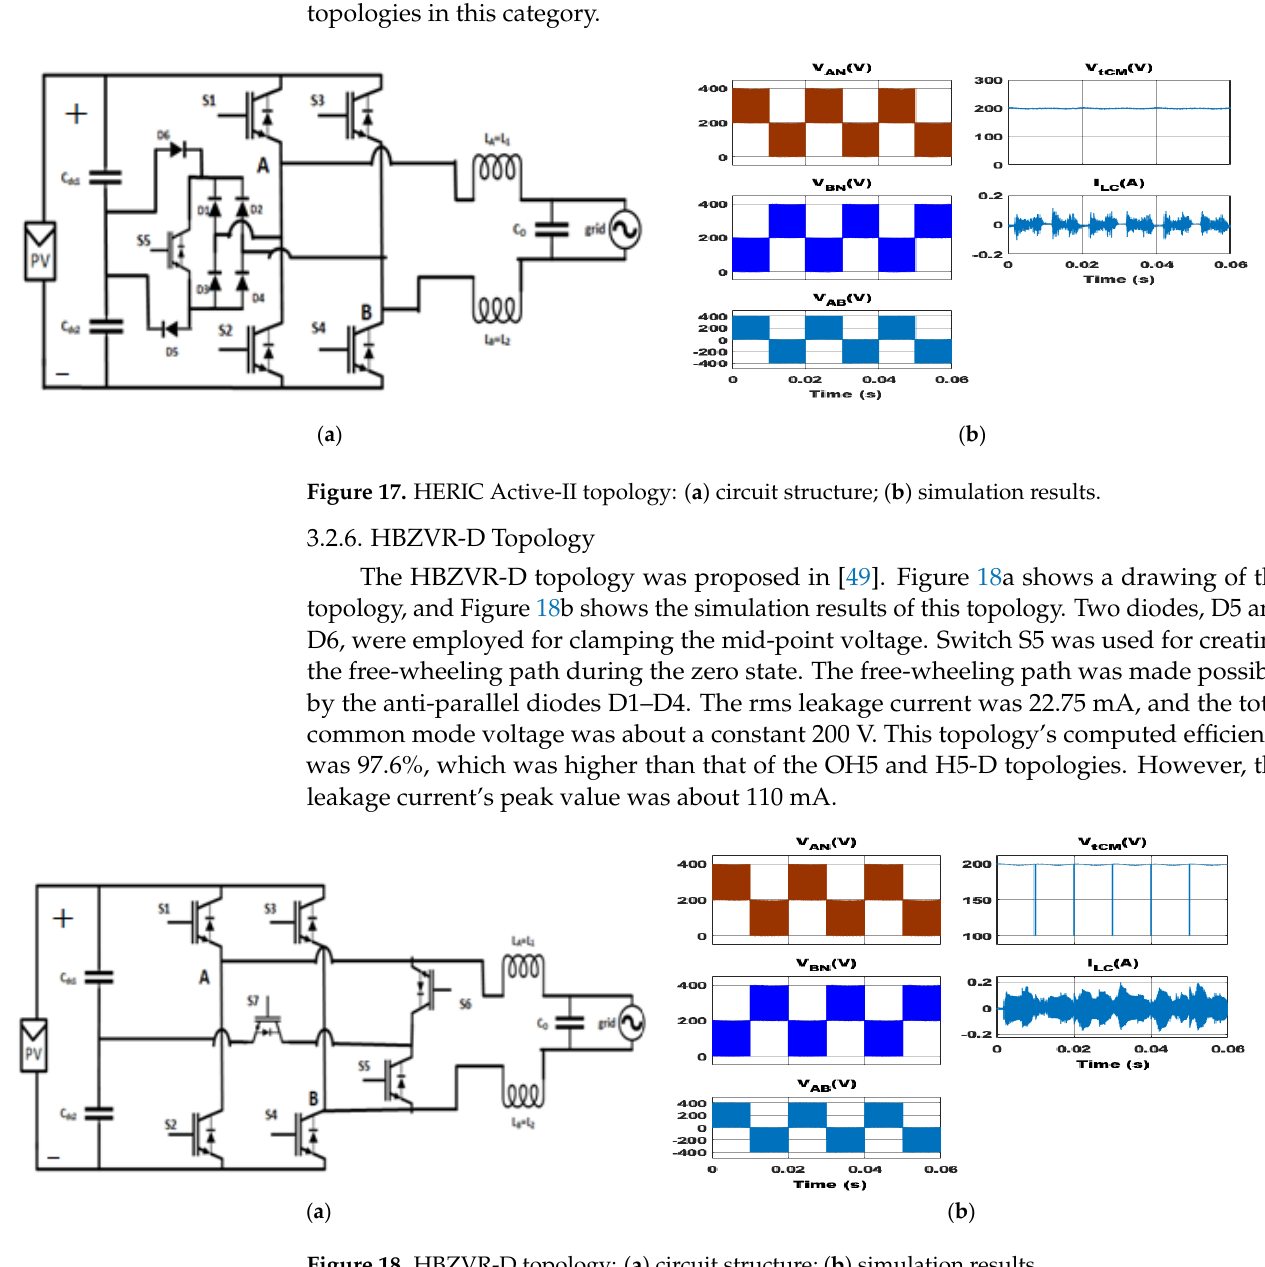
Figure 17. HERIC Active-II topology: ( a ) circuit structure; ( b ) simulation results.